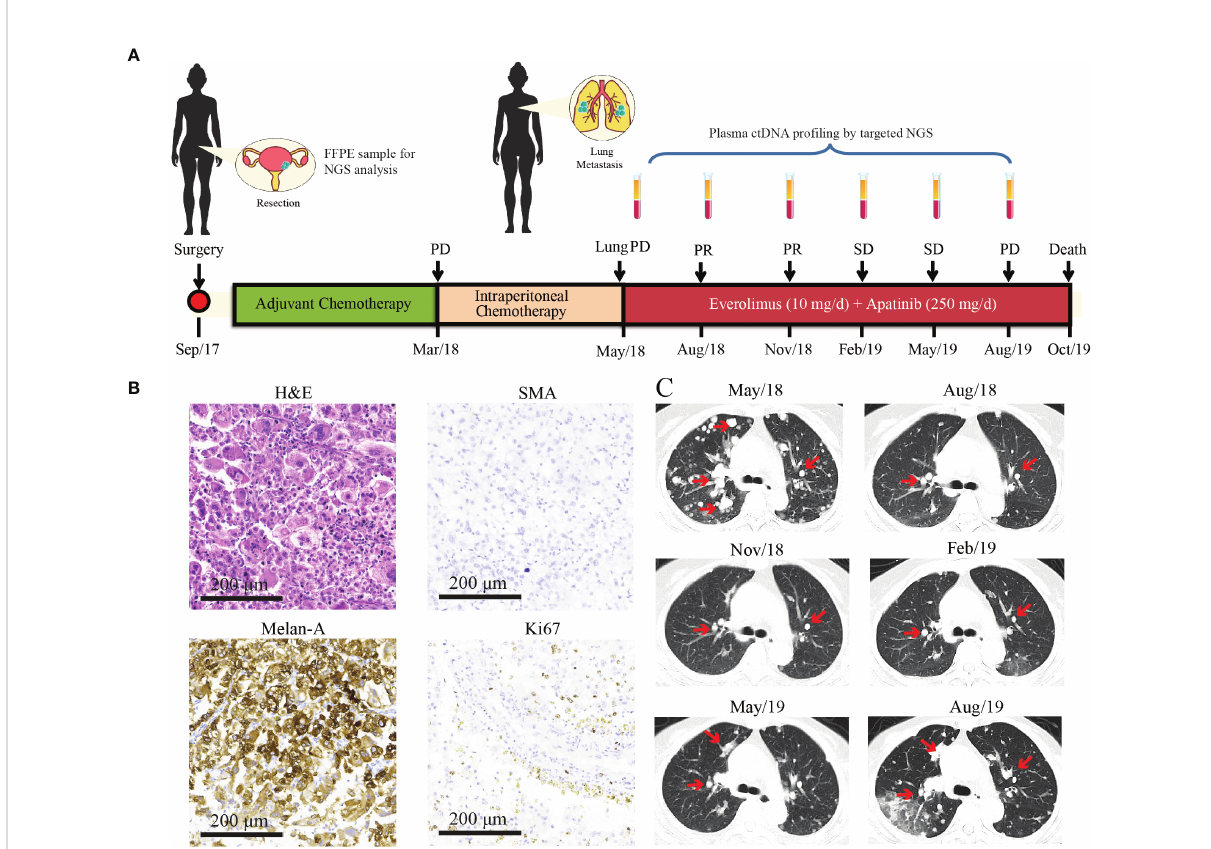
FIGURE 1 Treatment history and clinical information of the presented case. (A) The medical history of the presented case is shown with information about treatment timeline, response evaluation, and sample collection timepoints. During the combination treatment with everolimus and apatinib, plasma ctDNA sequencing was performed every 3 months along with treatment response evaluation as indicated by the arrowheads. (B) H&E staining and immunohistochemical (IHC) examinations (×200) of the primary uterine PEComa which was negative for the SMA marker and positive for Melan-A (90%). The Ki67 index is 20%. (C) CT images of lung metastases during everolimus and apatinib treatment. Lesions are indicated by the red arrows. PR, partial response; SD, stable disease; PD, progressive disease; NGS, next-generation sequencing; PEComa, perivascular epithelioid cell tumors; ctDNA, circulating tumor DNA; FFPE, formalin- fi xed, paraf fi n-embedded; H&E, hematoxylin and eosin; SMA, smooth muscle